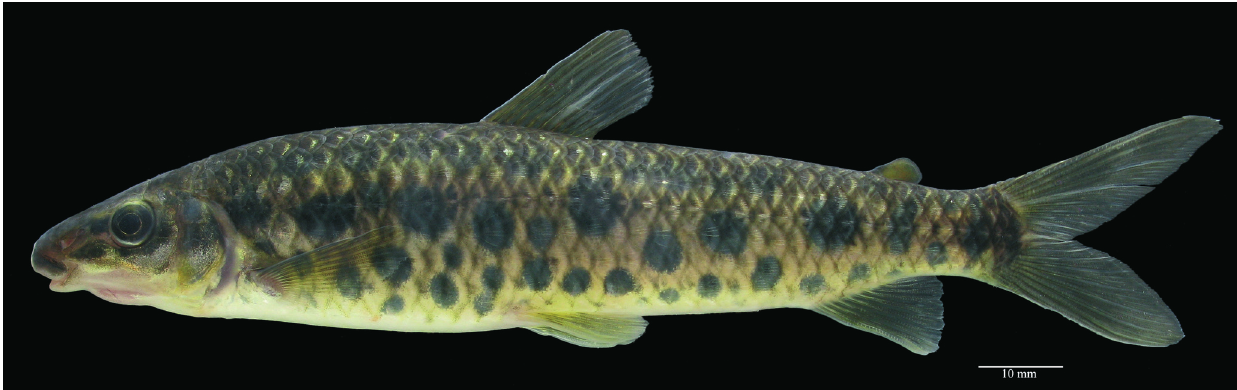
Fig. 2. Leporinus guttatus , live specimen, paratype, MZUSP 101300, 124.7 mm